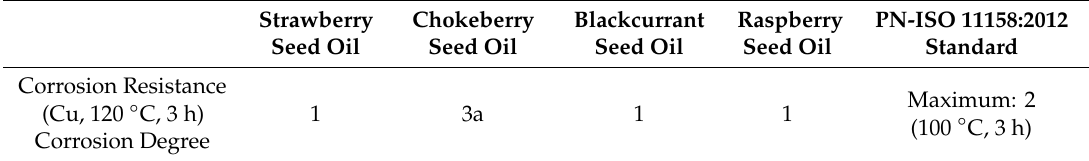
Table 3. The corrosion resistances of the tested vegetable